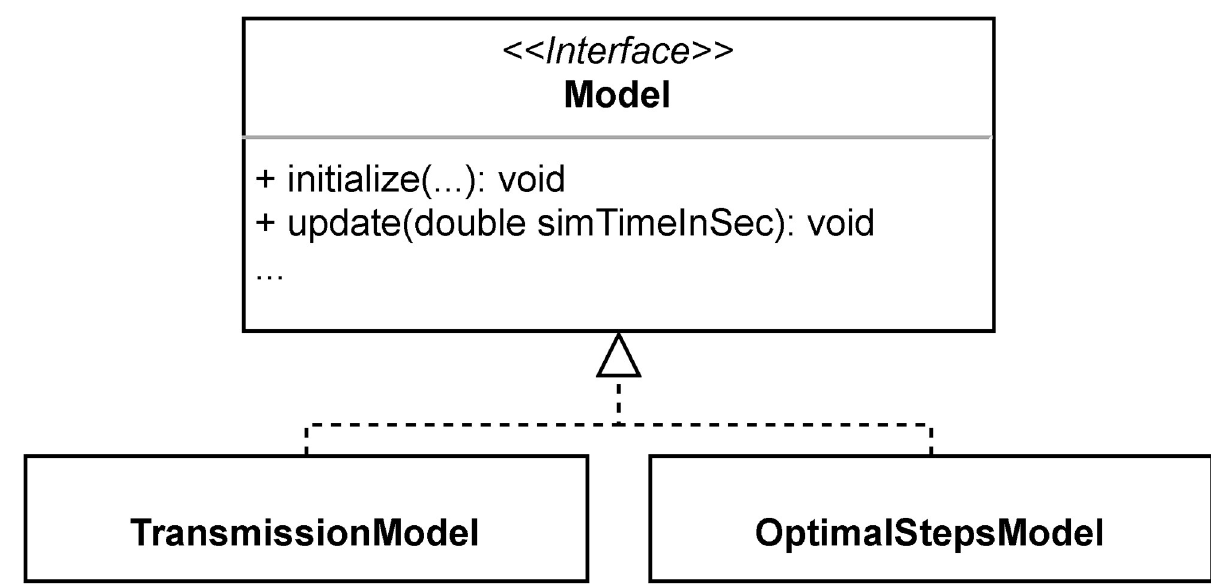
Fig 3. Class TransmissionModel. The class TransmissionModel contains the model core. Similar to the locomotion model OptimalStepsModel , it implements the interface Model .